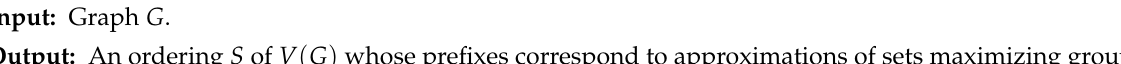
Algorithm 3 Computing Freeman group degree centralization